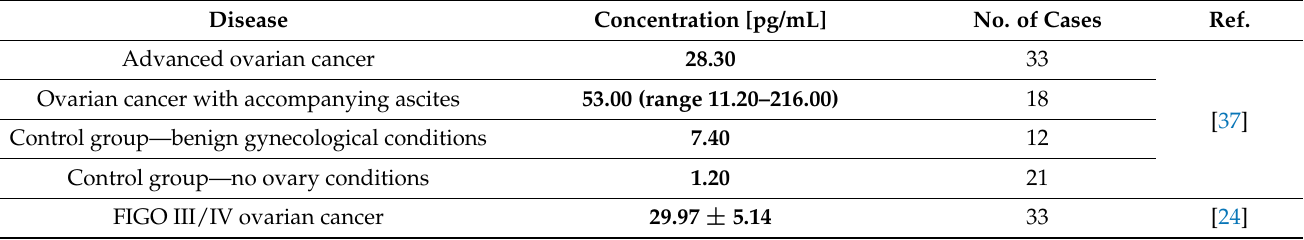
Table 4. Concentrations of interleukin 6 (IL-6) in blood (plasma/ serum